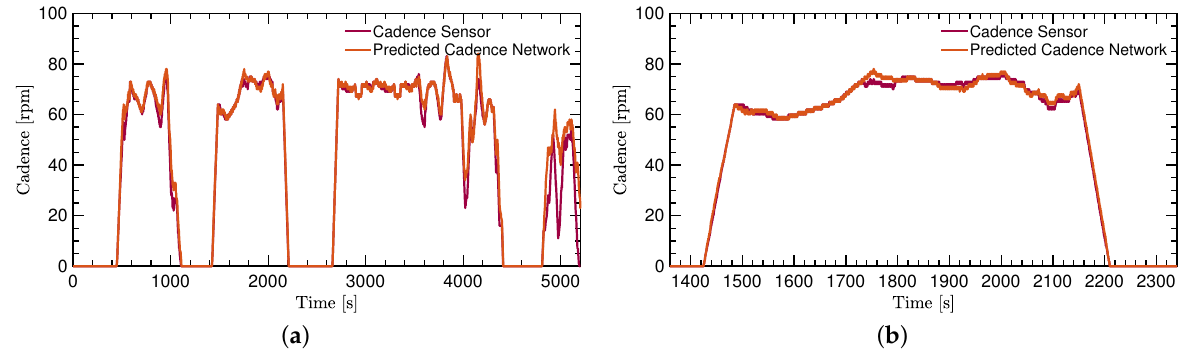
Figure 5. Neural network evaluation: true cadence as measured with the Hall-effect sensor versus predicted cadence from the network. ( a ) Comparison for a large section from the test dataset. ( b ) Comparison for a zoomed section from the test dataset.